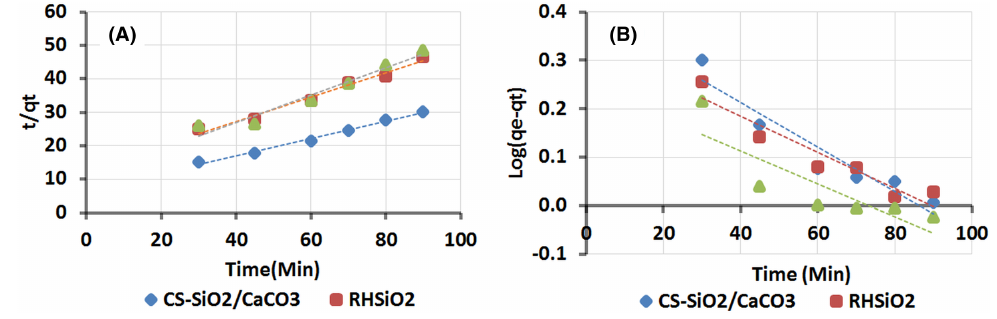
Figure 5 Kinetic adsorption study of phenol (A) Pseudo-second order model (B) Pseudo- fi rst-order model. Adsorption condition: pH 5.4, phenol concentration of 25 mg/L, adsorbent dose of 0.15 g at 120 rpm.